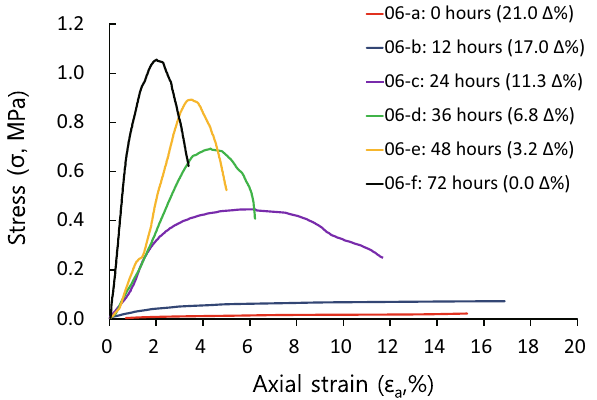
Figure 9. Stress–strain curves from unconfined compression tests performed on specimen set S-6. Both UCS and slope (E) in the stress–strain curves increase as water content decreases (from S-6a to S-6f). Specimens S-6a and 6b show continuous creep behavior as strain increases. Specimen S-6f shows elastic–plastic deformation and specimens S-6c–e show plastic–elastic–plastic deformation. The numbers in parentheses indicate the water content for each sample after a given drying time.